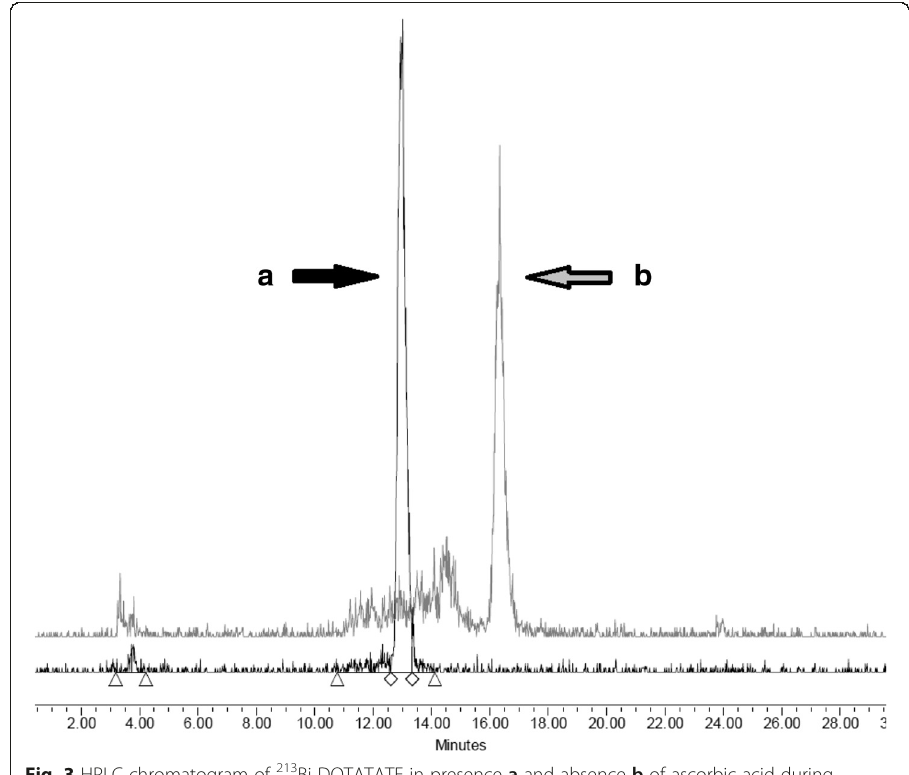
Fig. 3 HPLC chromatogram of 213 Bi-DOTATATE in presence a and absence b of ascorbic acid during labelling (n ≥ 3). Peak A; RT = 13.0 min and peak B; RT = 16.3 min. The y-axis represents the detected